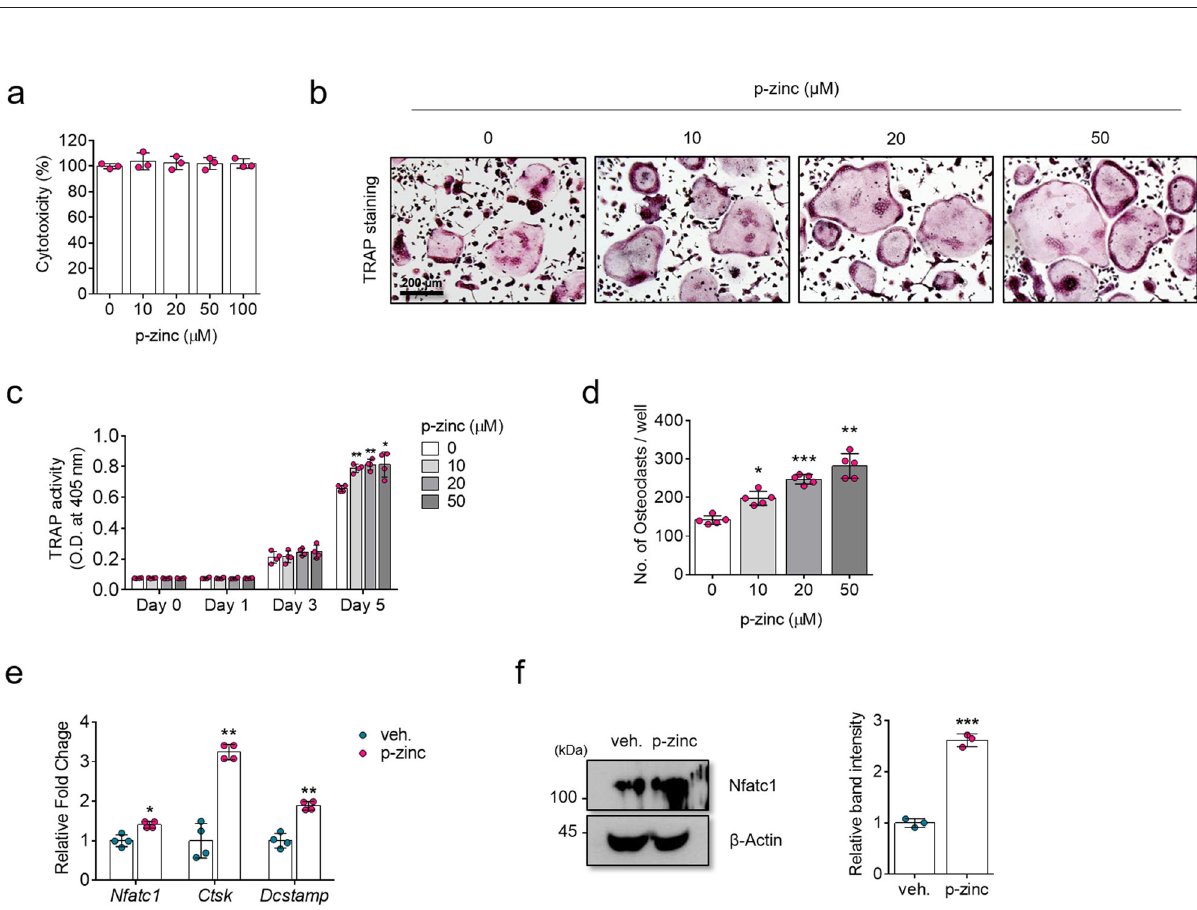
Fig. 1 Schematic of the study and effects of polaprezinc on the osteogenic differentiation of hBMSCs. a Human bone marrow-derived mesenchymal stem cells (hBMSCs) and mouse bone marrow-derived monocytes (mBMMs) were used for in vitro studies. For animal studies, ICR mice aged 8 weeks were used for further in vivo analysis. Polaprezinc was daily administered by oral gavage. b The Ez-Cytox assay was used to determine the cellular toxicity of polaprezinc-treated hBMSCs. Each experiment was performed in triplicate ( n = 3). ** P < 0.01 compared with vehicle-treated hBMSCs. c hBMSCs treated with vehicle or polaprezinc (10, 20, and 50 μ M) were incubated in osteogenic medium for 7 days. ALP staining was performed to determine the extent of the initial differentiation at day 7. Scale bar = 200 μ m. d Graphs were generated from real-time quantitative PCR data using RNA extracted from hBMSCs treated with polaprezinc (50 μ M) under osteogenic conditions for 3 days. The results were compared to those of the group treated with vehicle ( n = 3 experimental replicates). e Alizarin red S staining was performed to detect mineral deposition on day 14. Scale bar = 200 μ m. f The ALP activity assay was performed for the quantitative analysis of ALP staining. The absorbance was measured at 405 and 450 nm and normalized to that of alamar blue staining. g For quantitative analysis of alizarin red S staining, absorbance was measured at 595 nm following destaining with 10% cetylpyridinium for 30 min. * P < 0.05 and ** P < 0.01 compared with vehicle-treated hBMSCs. h The protein level for RUNX2 was analyzed in hBMSCs using western blotting for cells treated with vehicle or polaprezinc (50 μ M) under osteogenic conditions for 5 days. The band intensity was quanti fi ed using ImageJ software ( n = 3, in